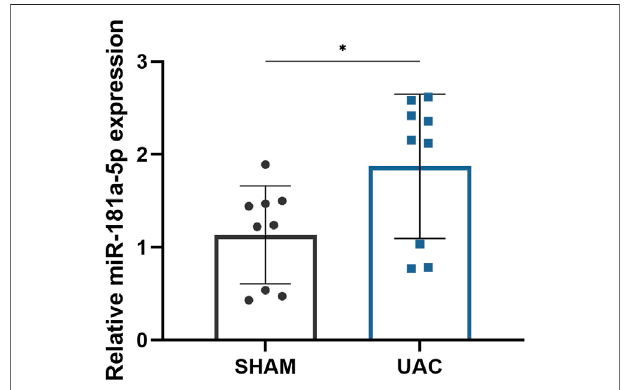
FIGURE 2 | Comparison of relative miR-181a-5p expression in healthy and osteoarthritis(OA)condylarcartilage.RelativemiR-181a-5p expression in healthy and OA condylar cartilage was determined by qRT-PCR using U6 as internalcontrol. n =9/group.DatapresentedasScatterdotplotwithbar (mean ± SD). Signi fi cance was determined using t-tests. * p < 0.05.